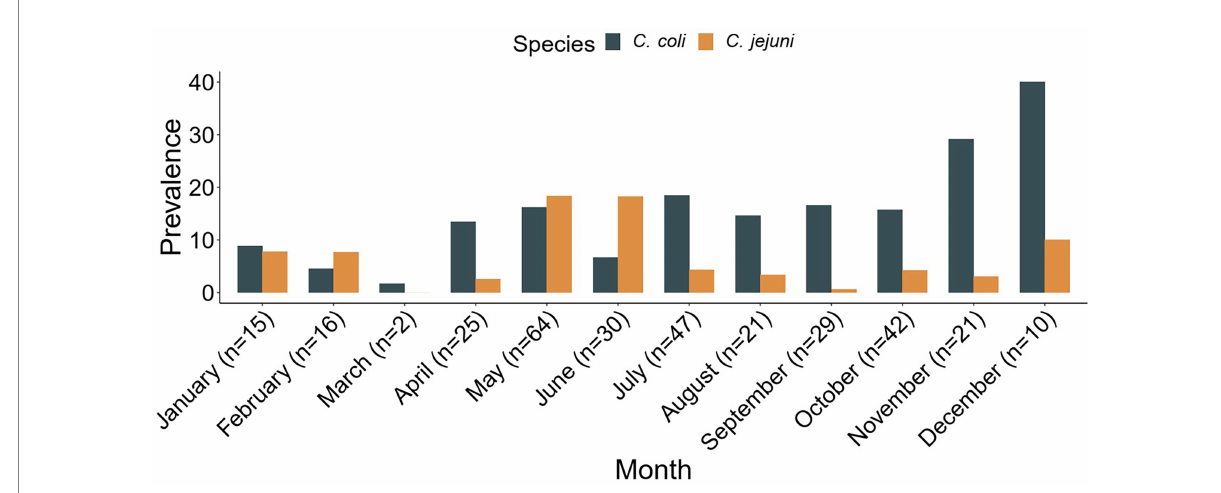
TABLE 3 Antibiotic resistance of C . coli and C . jejuni isolated from commercial and smallholder farm animals.